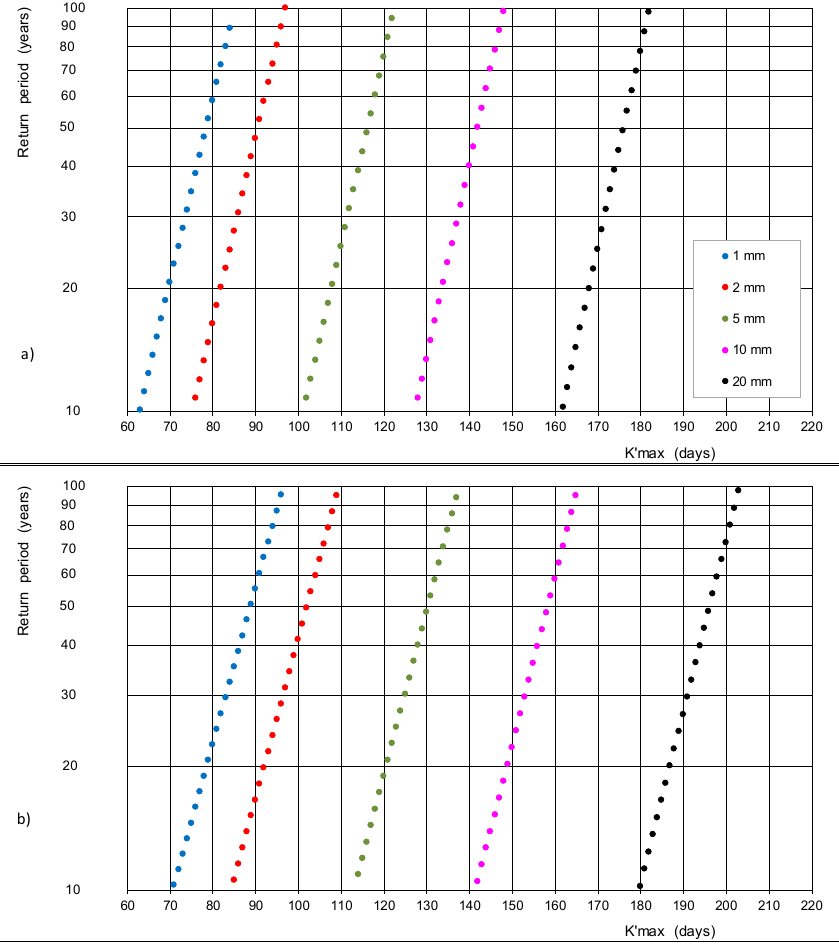
Figure 6. Estimated values of the dry spells duration k (cid:48) max (days) for di ff erent 30-year periods thresholds for the Cosenza rain gauge.